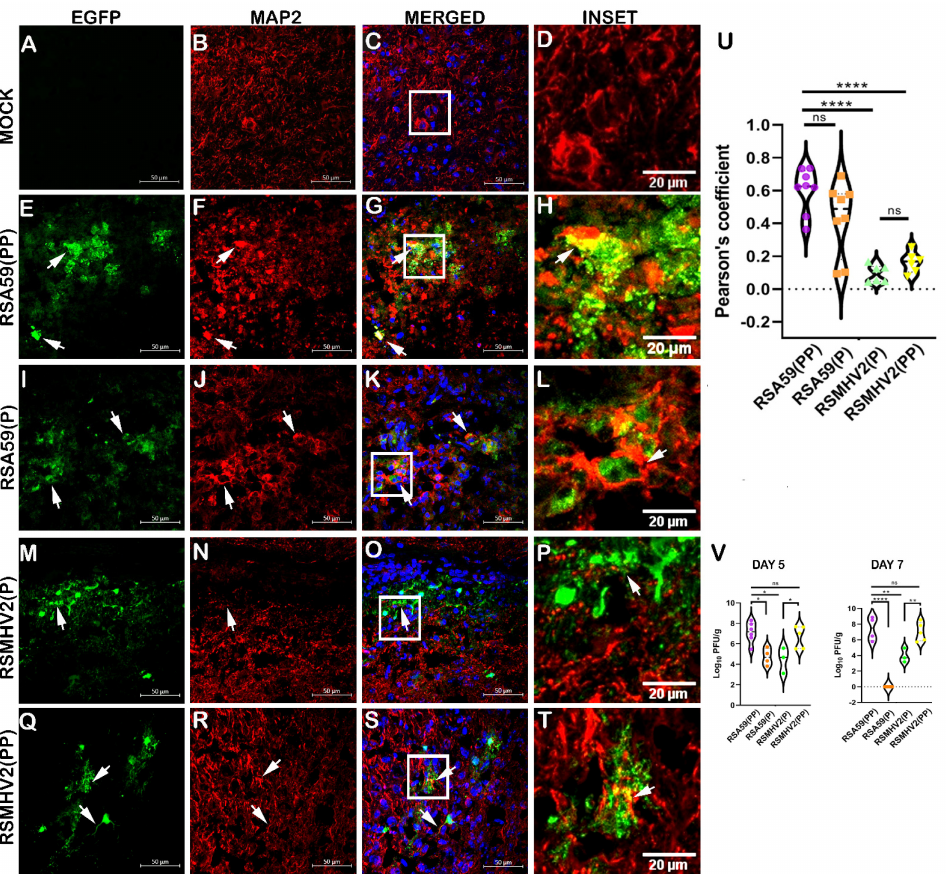
Figure 2. Colocalization study of two proline containing strains RSA59(PP), RSMHV2(PP) and single proline containing strains RSMHV2(P), RSA59(P) infected neurons in the brain of mice at day 5 p.i. Infected mice alongside control mock-infected mouse brain cryosections were immunofluorescently labeled with MAP2 antibody ( B , F , J , N , R ). EGFP panels indicate infected cells in the tissue ( A , E , I , M , Q ). Panels ( C , G , K , O , S ) show merged images of EGFP and MAP2 staining with arrowheads highlighting virus infected neurons. RSA59(PP) infected sections are in panel ( E – H ), RSA59(P) infected sections are in panel ( I – L ), RSMHV2(P) infected sections are in panel ( M – P ), RSMHV2(PP) infected sections are in panel ( Q – T ), and mock-infected sections are in panel ( A – D ). The insets marked by a white rectangle area in the merged panels show a magnified view of the colocalization of neurons with EGFP (seen as yellow) in panels ( D , H , L , P , T ). The amount of colocalization quantified as the Pearson coefficient was plotted in a violin diagram ( U ). Viral titer was performed at day 5 and day 7 p.i. to compare virus replication among RSA59(PP), RSA59(P), RSMHV2(P), and RSMHV2(PP). The results were plotted as a violin plot ( V ). The One-way ANOVA was used to compare RSA59(PP) with RSA59(P), RSMHV2(P), RSMHV2(PP), and RSMHV2(P) with RSMHV2(PP) infection. The level of significance was taken at p < 0.05, * p < 0.05, ** p < 0.001, **** p < 0.00001, and ns denotes